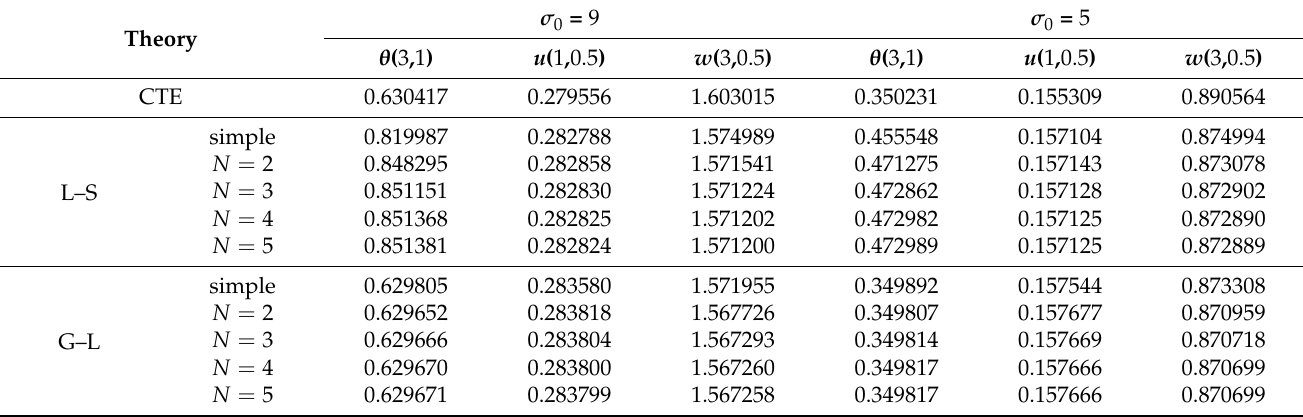
Table 3. Effect of initial stress σ 0 on the temperature θ and displacements u and w of the rotating half-space without initial pressure ( (cid:112) =